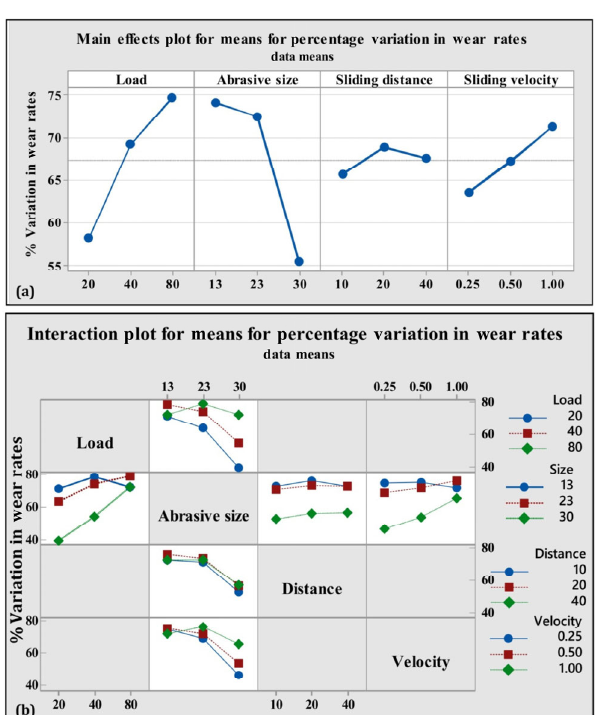
Fig. 7 (a) Main effects plots for means and (b) interaction plots of percentage variation in wear rates between alloy and composite, abbreviated as ∆ WR in the present study.